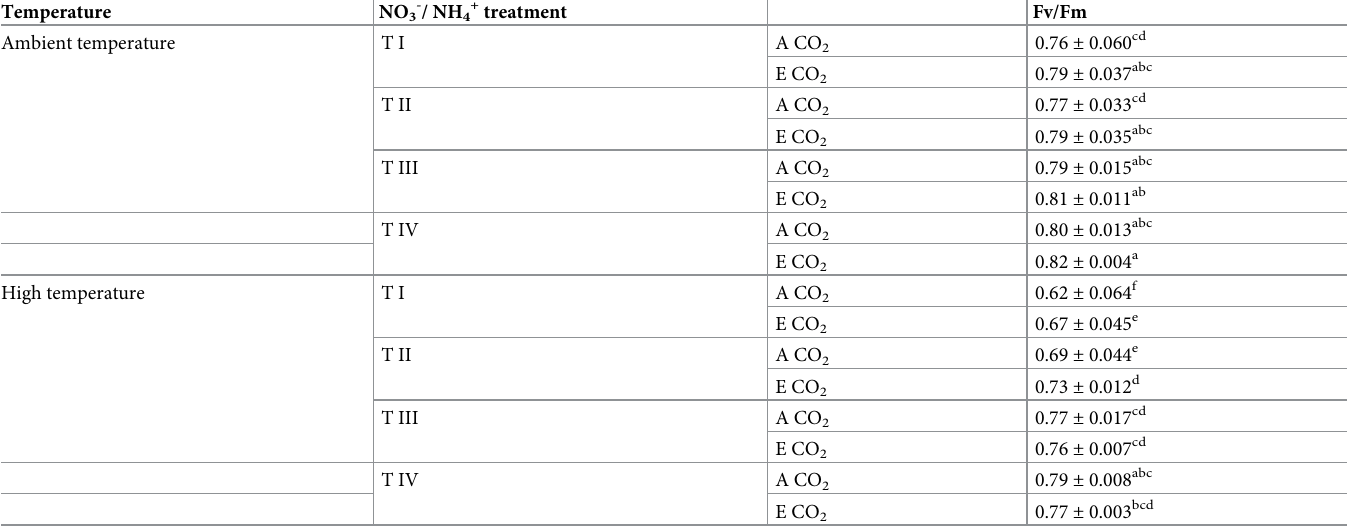
Table 2. Effect of heat stress, levels of CO 2 and different NO3-/NH4+ ratios on photosystem II maximum efficiency (Fv/Fm) in outer leaves of baby-leaf lettuce cv ‘Derbi’.